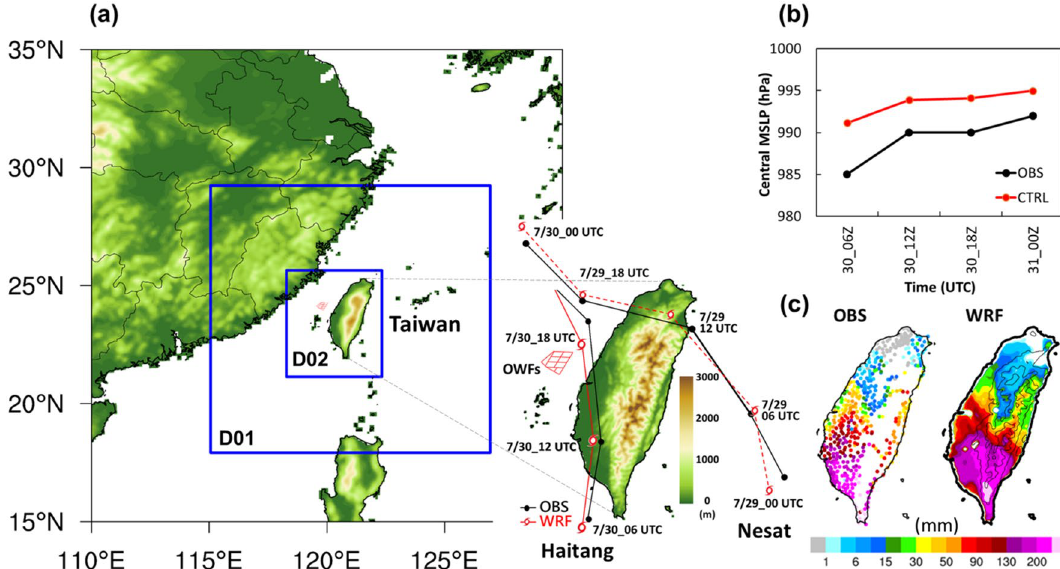
Figure 1. ( a ) Configuration of Weather Research and Forecasting model domain, topography, location of proposed offshore wind farms (OWFs) over Taiwan, and the comparisons of observed data (black line) and WRF model CTRL simulation (red line) of track. The simulated tracks of Typhoon Nesat and Tropical Storm Haitang are indicated by the dashed line and the solid line, respectively. OWFs location were indicated by the red area nearby western Taiwan. D01 and D02 indicate simulation domain 1 and domain 2, respectively. ( b ) Comparisons of observed (black line) and WRF model CTRL simulation (red line) in central minimum sea level 6.6.2 37